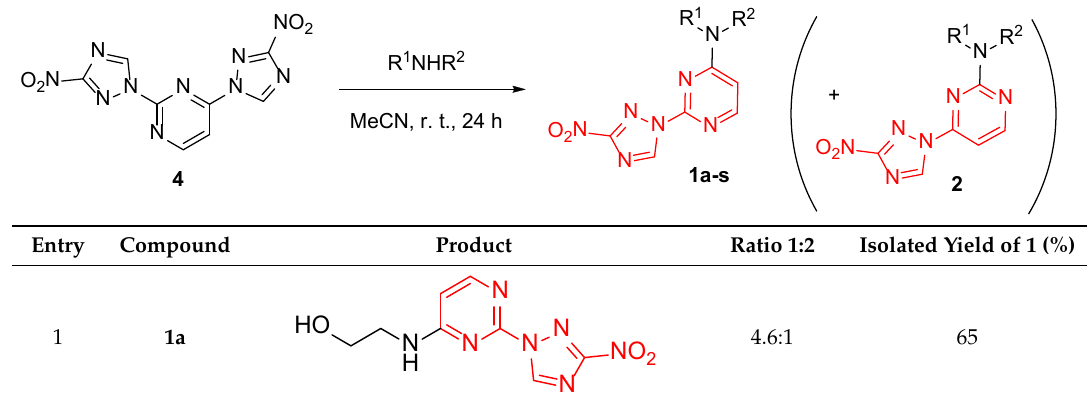
Table 1. Synthesis of 2-(3-nitro-1,2,4-triazol-1-yl)pyrimidines 1a-s .